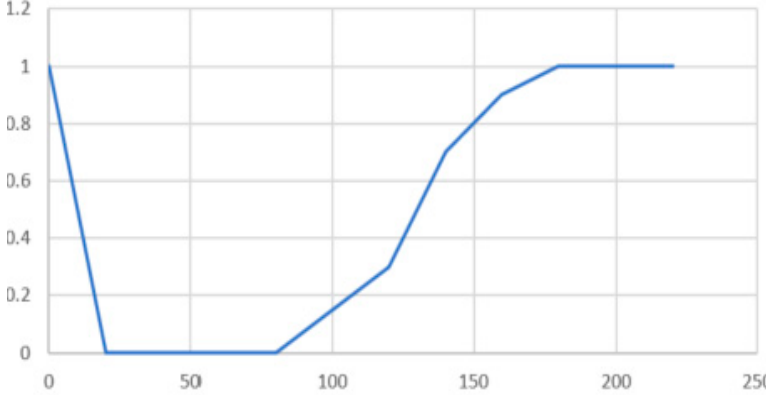
Figure 17. Resilience function depending R(t) on time for disruption at Location 1.